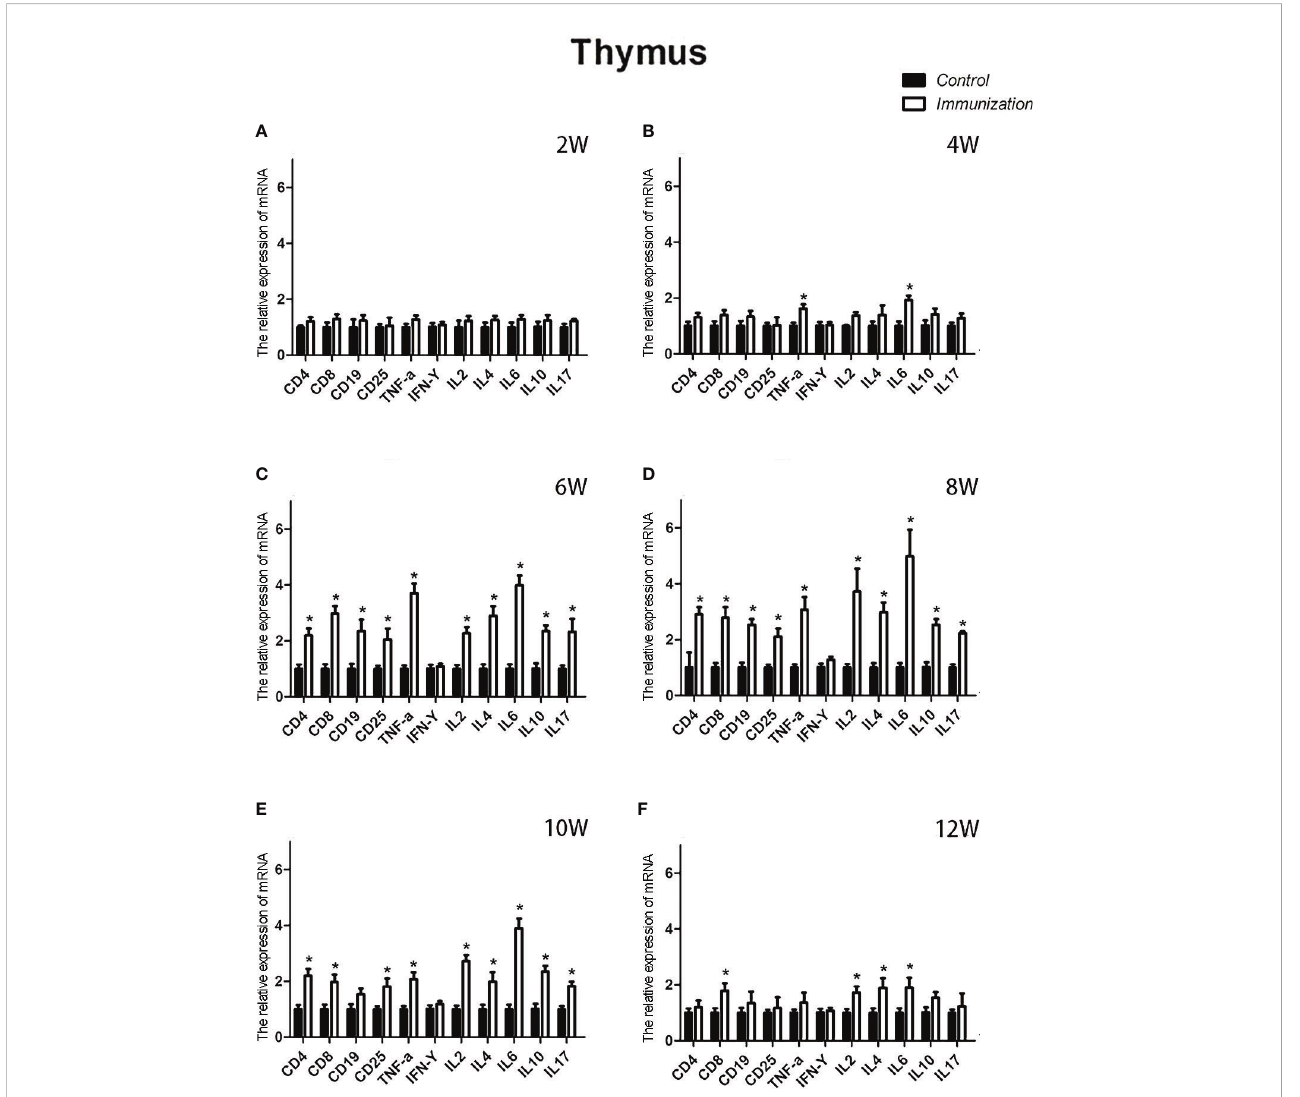
FIGURE 7 Mean (± SEM) of the effects of gonadotropin-releasing hormone (GnRH) immunization on the mRNA expression levels of immunity-related genes in the thymus of the control (n = 35) and GnRH immunization (n = 35) groups. (A-F) represent the detection time at different ages. * Indicates a signi fi cant difference ( P <